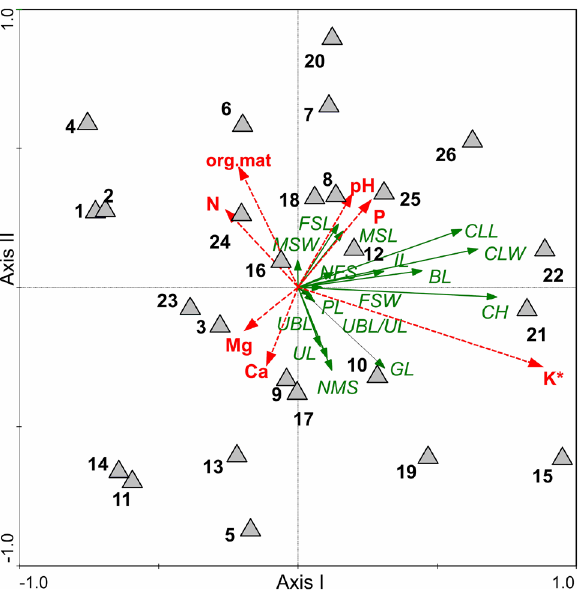
Figure 5. Ordination plot of populations (triangle), morphological traits and soil properties along the first two RDA axes; org. mat., organic matter content; pH, soil pH; N, nitrogen; P, phosphorus; K, potassium; Ca, calcium; *variables statistically significant (p ≤ 0.05). For trait codes see Table 2. The populations are numbered as in Table